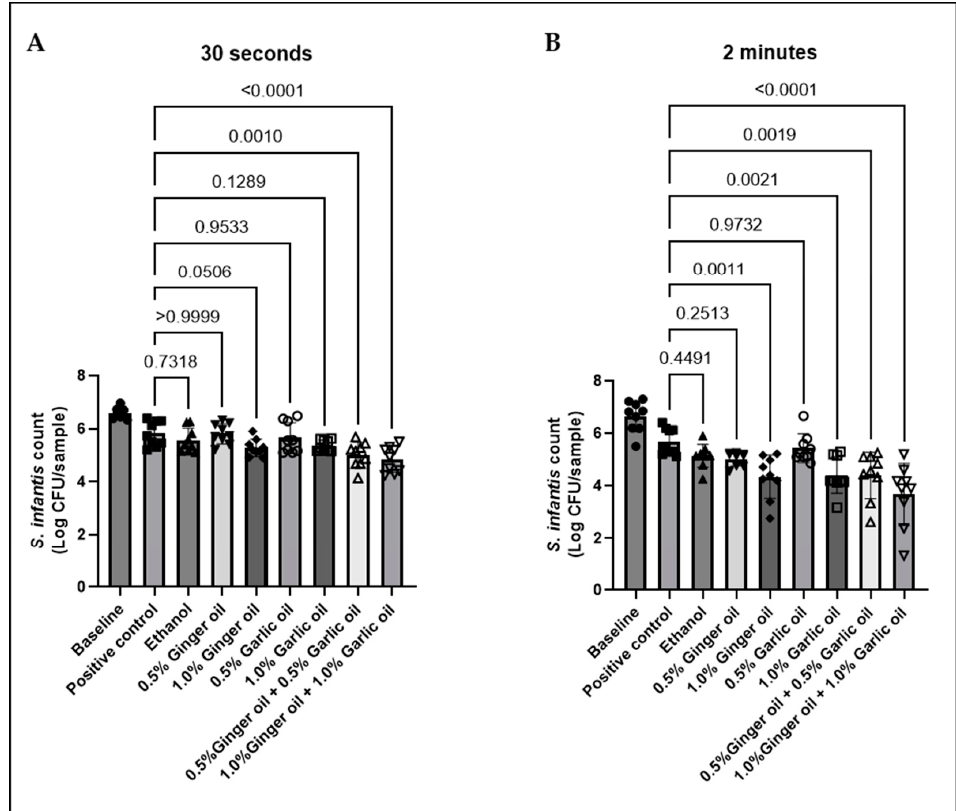
Figure 1. Chicken skin samples were inoculated with 7.55–8.1 Log CFU/sample of S. Infantis and dipped in 56 °C solutions containing ginger or garlic oil alone or in combination for 30 s ( A ) or 2 min ( B ). Results are averages of three independent trials, each containing triplicate samples (mean and STD). The estimated p -values are included above the bars.